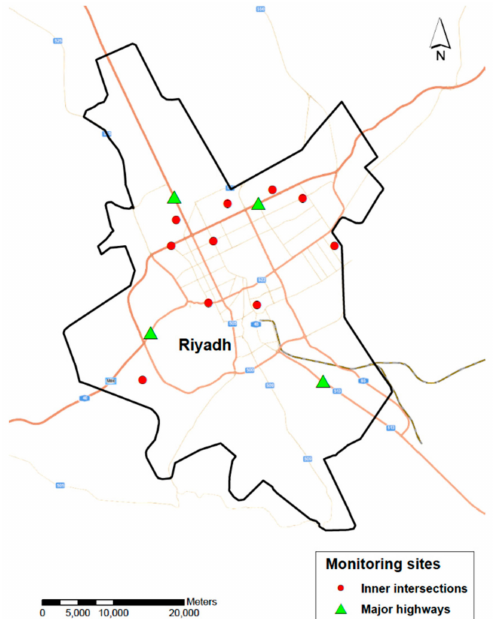
Figure 1. Observation sites for seatbelt and mobile violations in